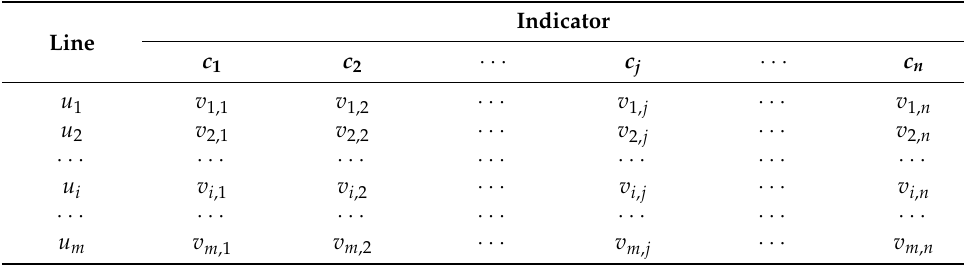
Table 1. Ordered initial decision indicator table of the construction